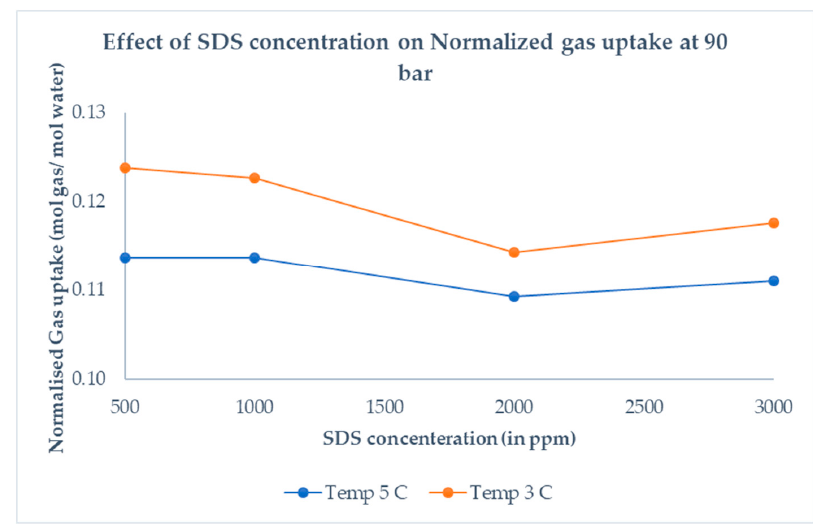
Figure 11. Normalized gas uptake vs. SDS concentration at 3 °C and 5 °C temperature for fresh SDS sample and initial pressure 90 bars. At the lower operating temperature, higher normalized gas uptake is observed, following a similar pattern of the hydrate saturation curve.